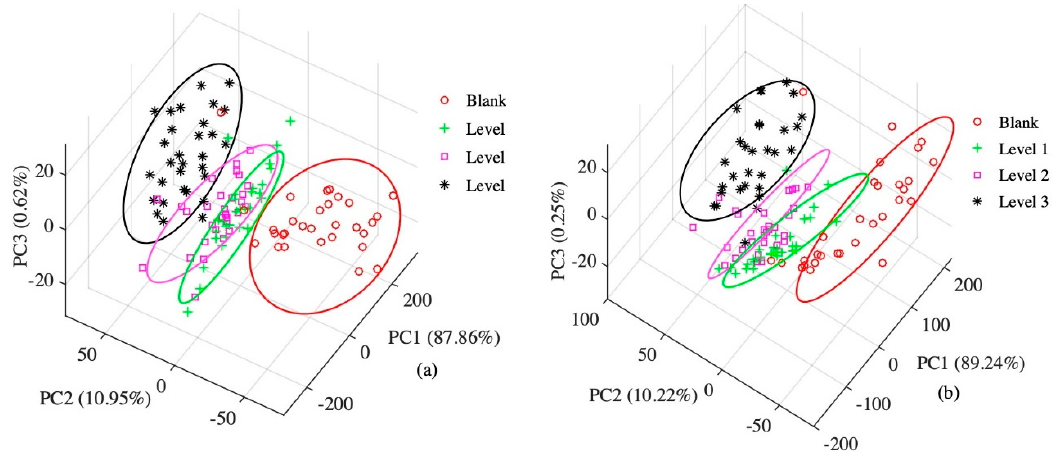
Figure 3. ( a ) Principle component analysis (PCA) results using data from all sensors; ( b ) feature sensors.